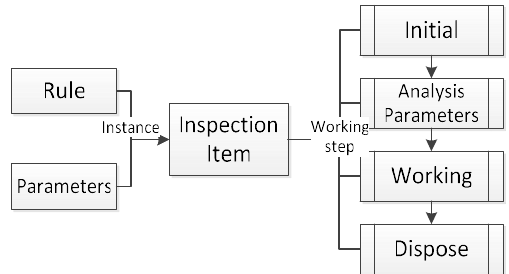
Figure 5. The structure of the inspection cloud